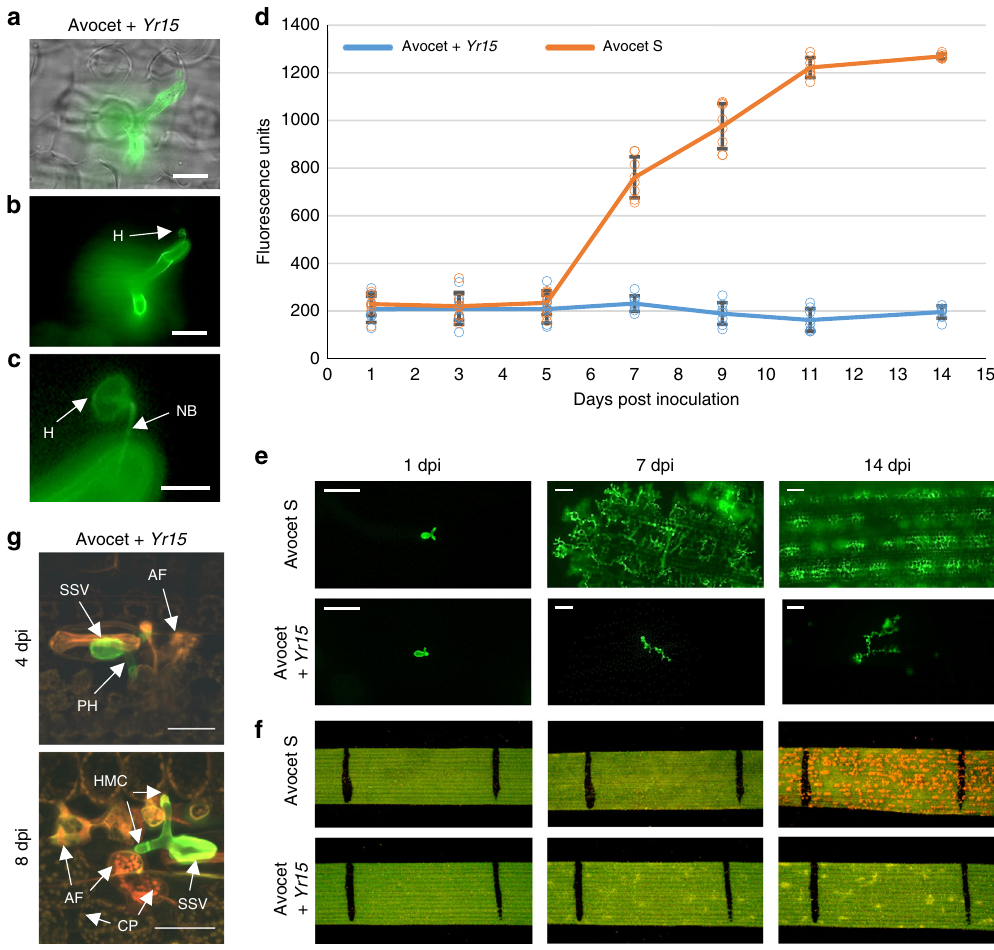
Fig. 1 Fungal development in Pst -infected Avocet S and Avocet + Yr15 NILs during 14 days post inoculation (dpi). a – c Pst haustorium (H) within invaded plant host cell observed in Avocet + Yr15 at 3 dpi under bright fi eld ( a ) and fl uorescence ( b ), connected to HMC via neckband (NB; c ). Bars = 20 µ m ( a , b ), 5 µ m ( c ). d Comparative amounts of fungal biomass (chitin) within leaf tissues of NILs during 1 – 14 dpi. Error bars denote standard deviation (s.d.) based on eight biological replicates. e Fluorescence micrographs of fungal colonies and feeding structures at 1, 7, and 14 dpi in susceptible and resistant NILs. Bars = 100 μ m. f Leaf segments at 1, 7, and 14 dpi in susceptible and resistant NILs. The black lines delineate a 1 cm segment in the middle of the second leaf of the same plant. g Fungal structures and host responses in Avocet + Yr15 at 4 and 8 dpi. The fungal colony (in green) consist of a substomatal vesicle (SSV) and primary infection hyphae (PH) with haustorial mother cells (HMC). Indicative signs of host cell auto fl uorescence (AF) are visible already at 4 dpi, while at 8 dpi the infected host cells show bright orange AF and appear to be collapsed and distorted; a couple of them contain aggregated chloroplasts (CP) with bright fl uorescence as an indicator of host HR. Bars = 40 µ